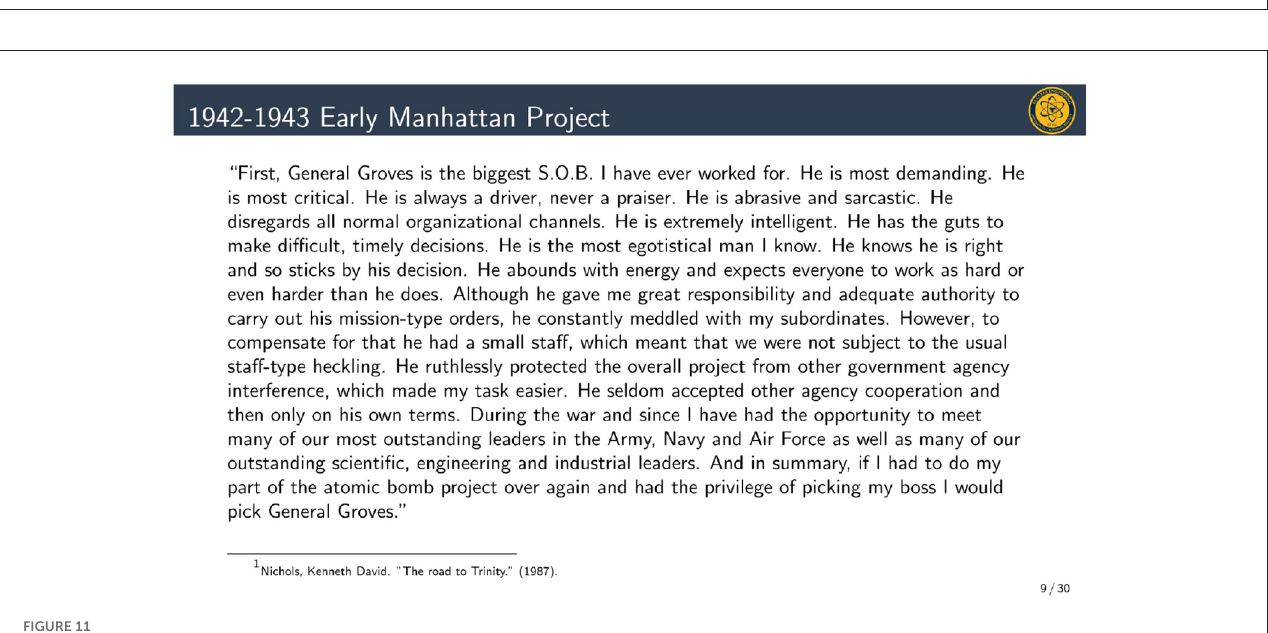
FIGURE10 Slide detailing organizational leadership and structure of early MED. Lecture W4L8.